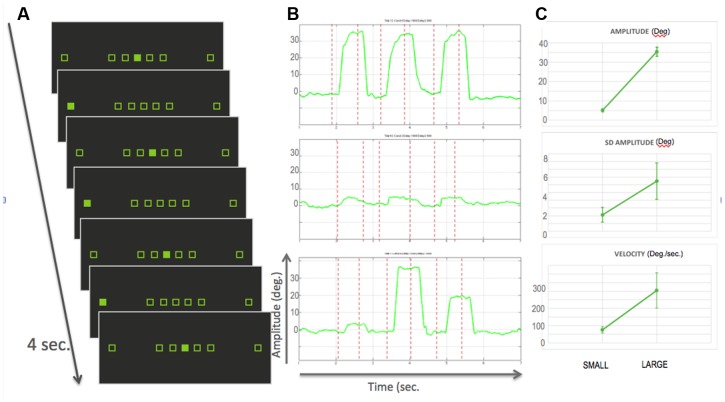
(A) Experimental design: the seven squared place-holders stayed displayed on the monitor for the whole experiment. Participants were required to gaze to the filled square, thereby performing small, large or medium size saccades. Each bock consisted of six saccades in 4 seconds. The experiment was an alternation of blocks with either only small, only large saccades or a mix of the three sizes. Two blocks were separated by a variable duration of fixation. (B) Example traces of saccades within a run for, from top to bottom, large, small and mixed blocks. Red dotted lines represent the onset of visual targets. (C)
Top: Average amplitude in degrees over the 17 participants for small and large blocks. Error bars represent standard deviation; Middle: average standard deviation of the amplitude, as a surrogate measure of spatial accuracy; Right: averaged velocity in deg./sec. As expected larger saccades were more variable and faster.